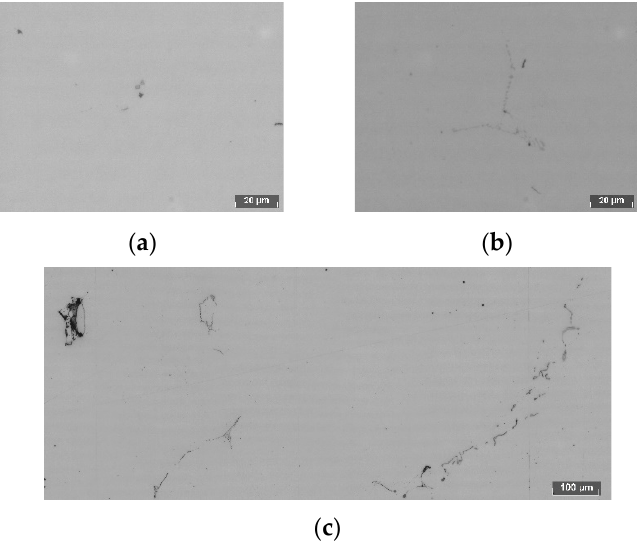
Figure 7. Nitrides at distances of 15 ( a ), 50 ( b ) and 90 ( c ) mm in